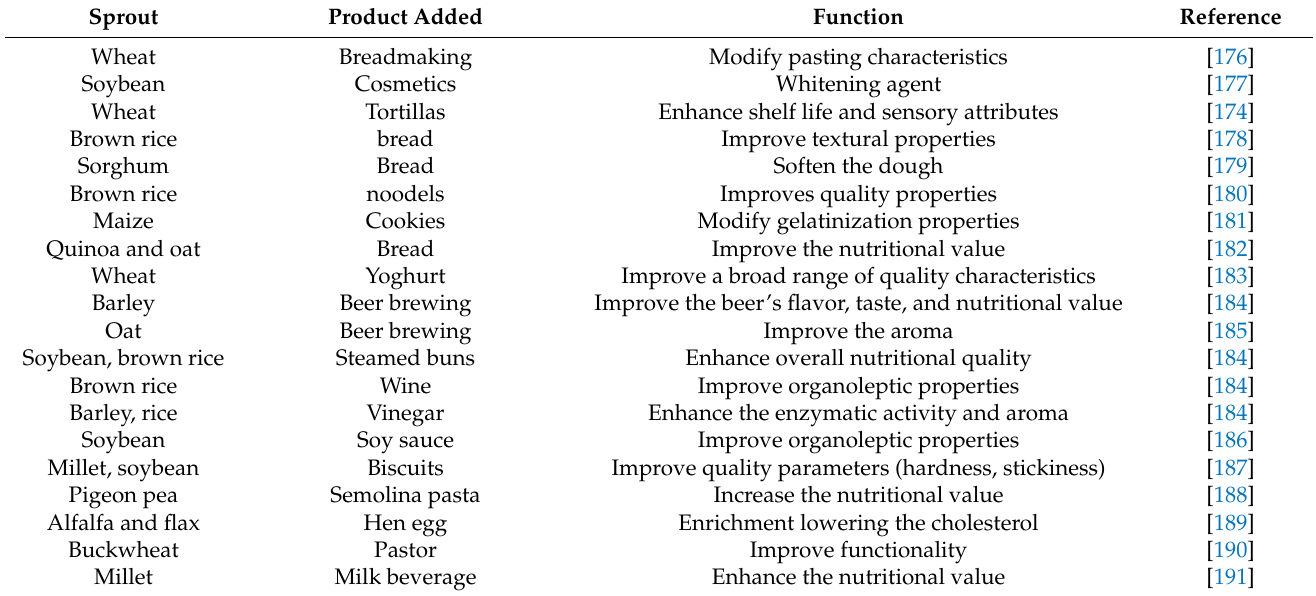
Table 3. Examples of studies reporting on the addition of sprouts in processed